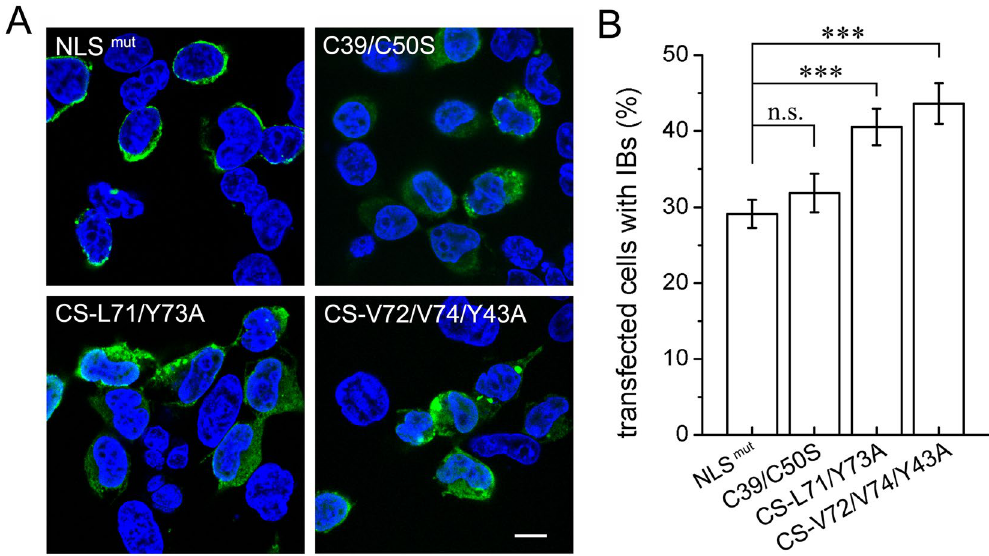
Figure 5. Immunofluorescence microscopic imaging of cytoplasmic inclusions of TDP-43-NLS mut and its dimer-interface mutants. ( A ) Inclusion formation of FLAG-TDP-43-NLS mut and its Cys mutant (C39/C50S) and dimer-interface mutants (CS-L71/Y73A and CS-V72/V74/Y43A) in HEK 293 T cells. TDP-43-NLS mut and its mutants were stained with mouse anti-FLAG (green), and the nuclei were stained with Hoechst (blue). The images are shown with a magnification of 3 times (3 X). Scale bar = 10 µ m. The mutants were generated based on FLAG-TDP-43-NLS mut . ( B ) Quantification of the cells with cytoplasmic inclusions in HEK 293 T cells overexpressing FLAG-TDP-43-NLS mut or its mutants. Cells were counted and the data were statistically analyzed by one-way ANOVA. Results are presented as Mean ± SEM (n = 25–30). *** p < 0.001; n.s., no